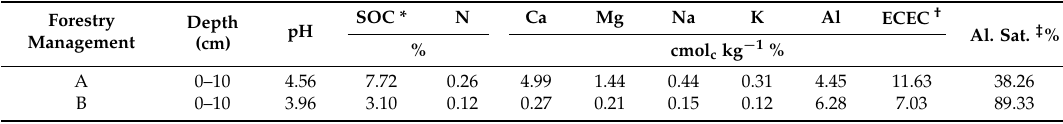
Table 9. Mean values of the chemical parameters of the